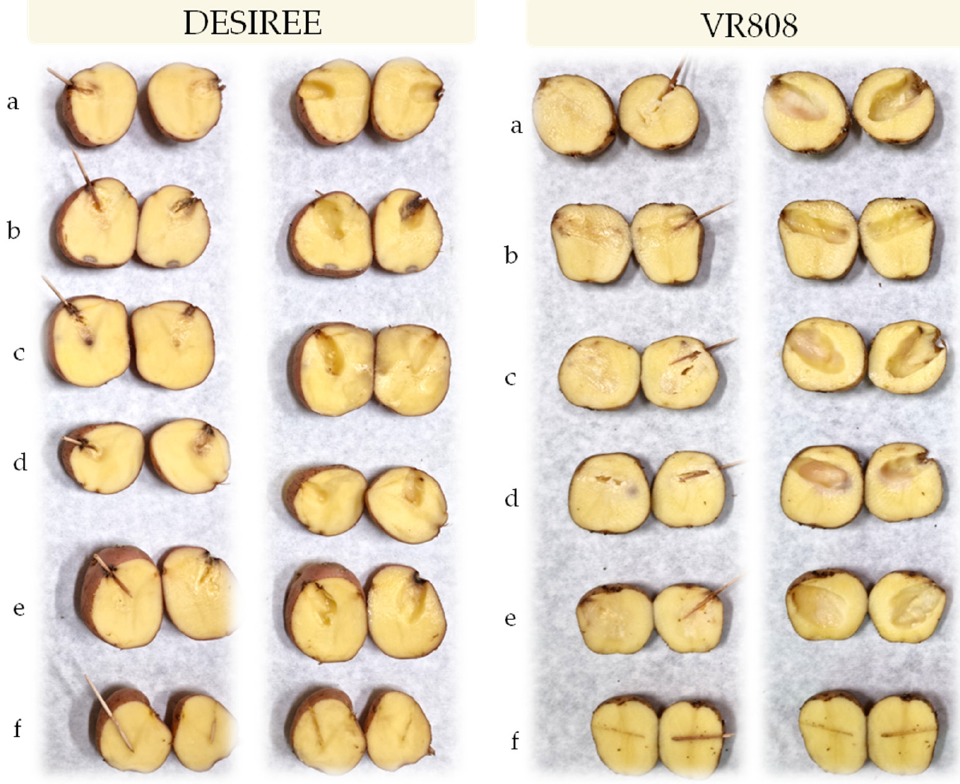
Figure 4. Potato tuber with soft rot registered 48 h post inoculation on cv. Desiree and VR808 inoculated with ( a )- P. brasiliense strain MMKC19, ( b )- P. carotovorum strain MMDC11, ( c )- P. punjabense strain MMZCVR2, ( d )- P. carotovorum strain DAPP-PG 752, ( e )- P. brasiliense strain LMG 21370, ( f )-negative control (left row—longitudinal section of the inoculated tuber; right row—tuber after the removal of macerated tissue).